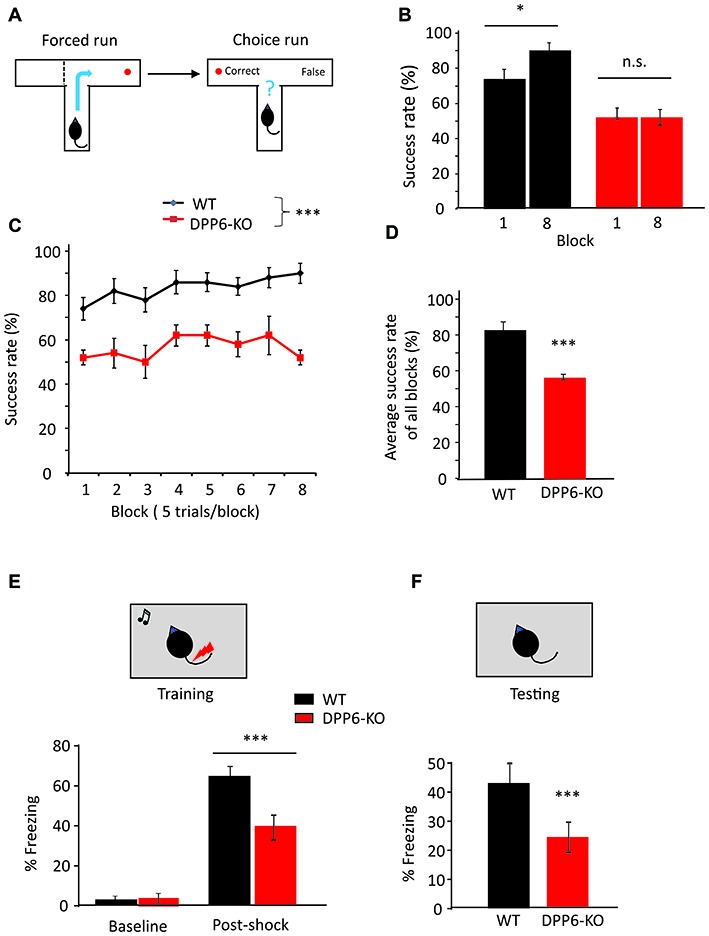
DPP6-KO mice show impaired spatial working memory in the T-maze and contextual fear conditioning tasks. (A) Schematic showing the experimental design in forced run and choice run of the T-maze task. (B) Percentage of correct choices for mice during the learning phase. (C) Percentage of correct choices comparing Day 1 to Day 8. (D) Percentage of correct choices for average scores over 8 days (n = 10 each group), compared with Student’s t-test. (E,F) Contextual fear conditioning task, at 24 h after training, DPP6-KO mice show a significant reduction in time exhibiting freezing behavior when placed back in the test chamber (n = 10 each group) (n.s. = not significant, *p < 0.05, ***p < 0.001).